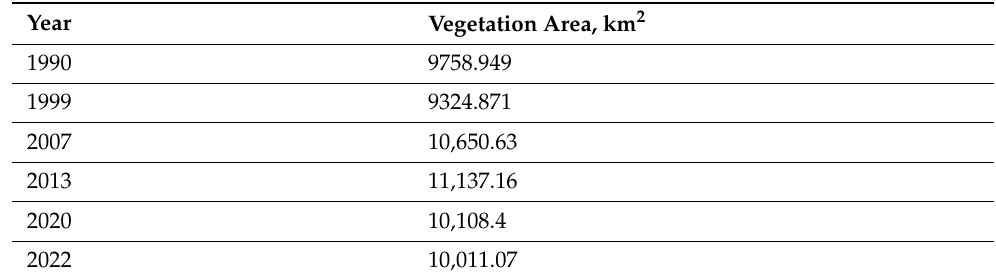
Table 5. Vegetation dynamics from 1990–2022 in the Tomsk